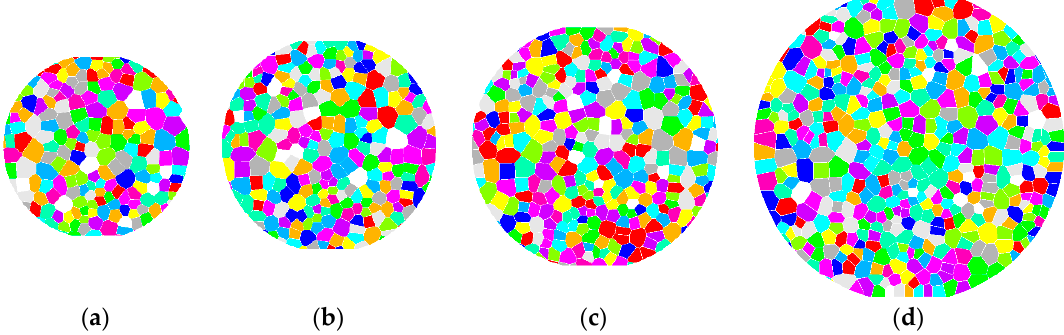
Figure 6. Crystal structure models of river ice with different sizes: ( a ) Specimen diameter is 60 mm; ( b ) Specimen diameter is 70 mm; ( c ) Specimen diameter is 80 mm; and ( d ) Specimen diameter is 100 mm.